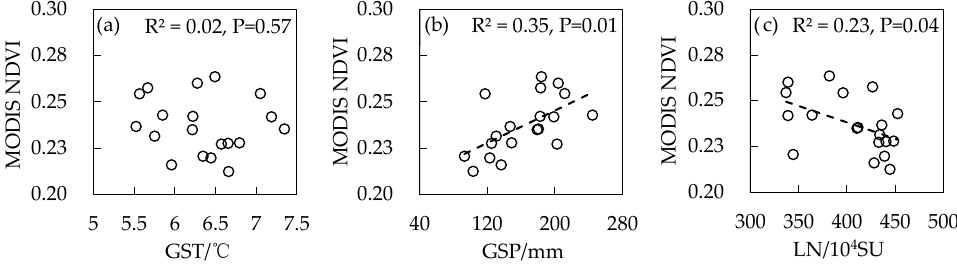
Figure 4. The relationships between NDVI and ( a ) GST, ( b ) GSP, and ( c ) LN.